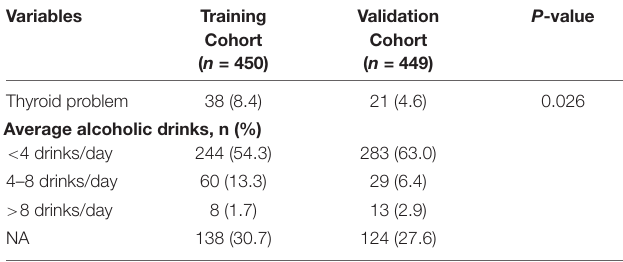
TABLE 1 | Baseline characteristics of MAFLD patients in the 2017–2018 NHANES.